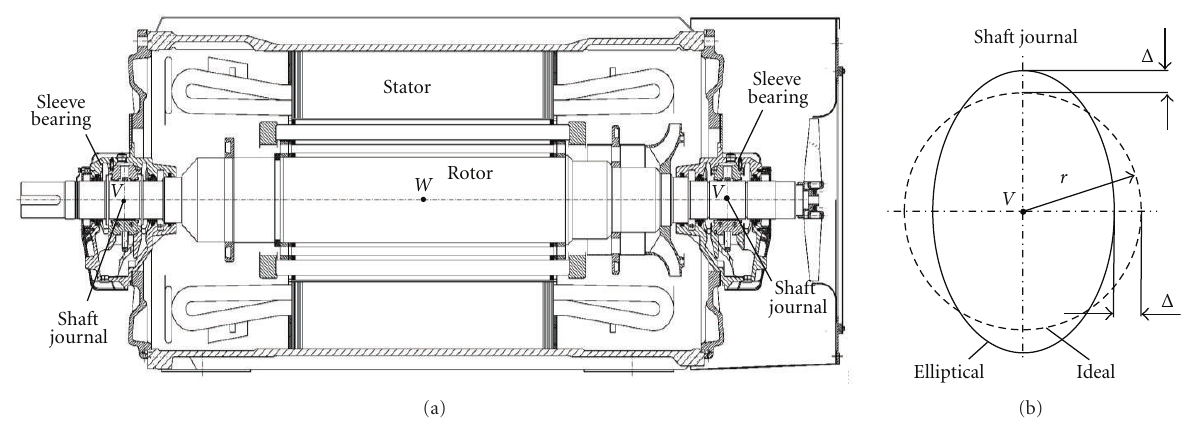
Figure 1: (a) Longitudinal section of a 2-pole induction motor with sleeve bearings. (b) Excitation due to elliptical shaft